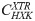
Validation of the parameter classification with reassignment.Control of HXK over XTR is negative (A) and positive (D) after constraining the inferred ranges of 6 parameters. Distribution of the control coefficient CHXKXTR for the case of negative (B) and positive (E) control. The inferred ranges of parameters that determined negative (C) and positive (F) control of HXK over XTR.